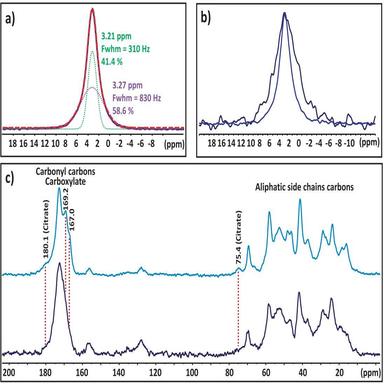
1D MAS NMR spectra: (a) 31P (νr = 60 kHz, relaxation delay 600 s) of Hu-dentin (blue) with spectral deconvolution (red), (b) 31P CP (νr = 60 kHz) of Hu-dentin with contact time of 10 ms (blue) and of 0.2 ms (black), with intensities normalized for their comparison, (c) 13C quantitative CP (νr = 12 kHz) of (top) Hu-dentin and (bottom) demineralized dentin (Dm-dentin). (For interpretation of the references to color in the text, the reader is referred to the web version of this article.)